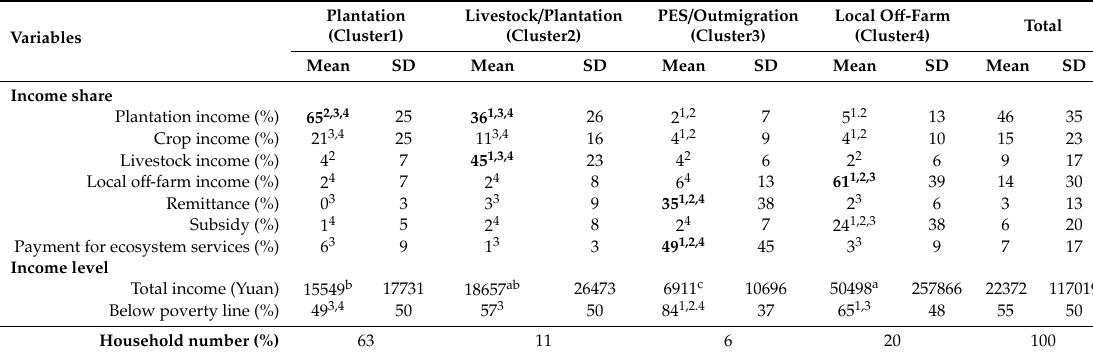
Table 1. Classification of rural household livelihood